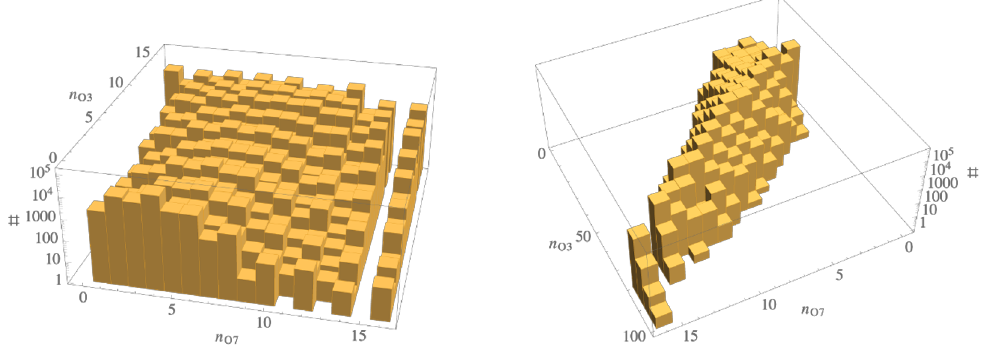
Figure 3 . Histograms showing on a logarithmic scale the number of orientifolds producing a given number of O7 planes n O 7 and O3 planes n O 3 . Left: the minimal number of O3 planes from resolution branches that do not produce extra O3 planes. Right: the maximal number of O3 planes from the resolution branches that produce one extra O3 plane per conifold